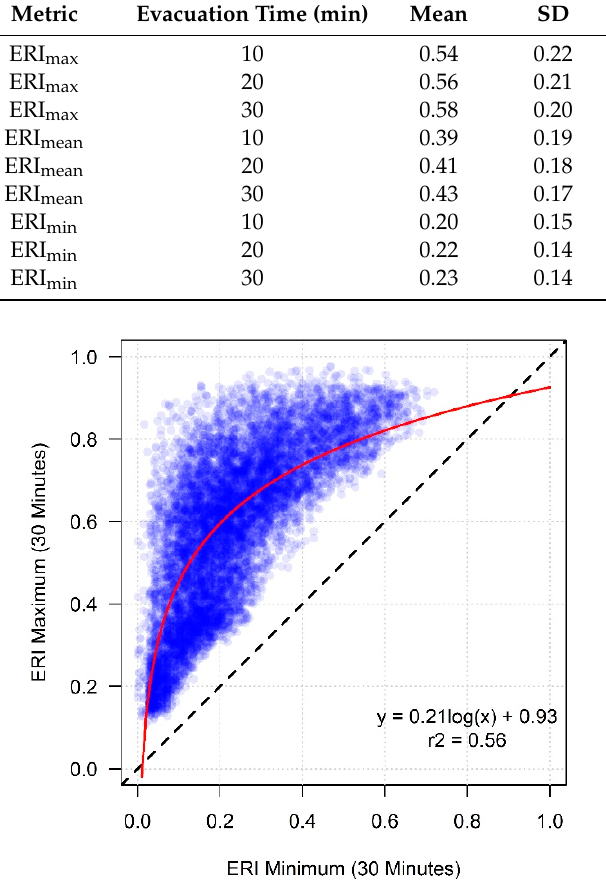
Figure 8. The relationship between ERI max and ERI min for a 30-minute evacuation time frame, where the red line represents a log-linear regression model, and the black dotted line represents a 1:1 relationship between ERI max and ERI min .